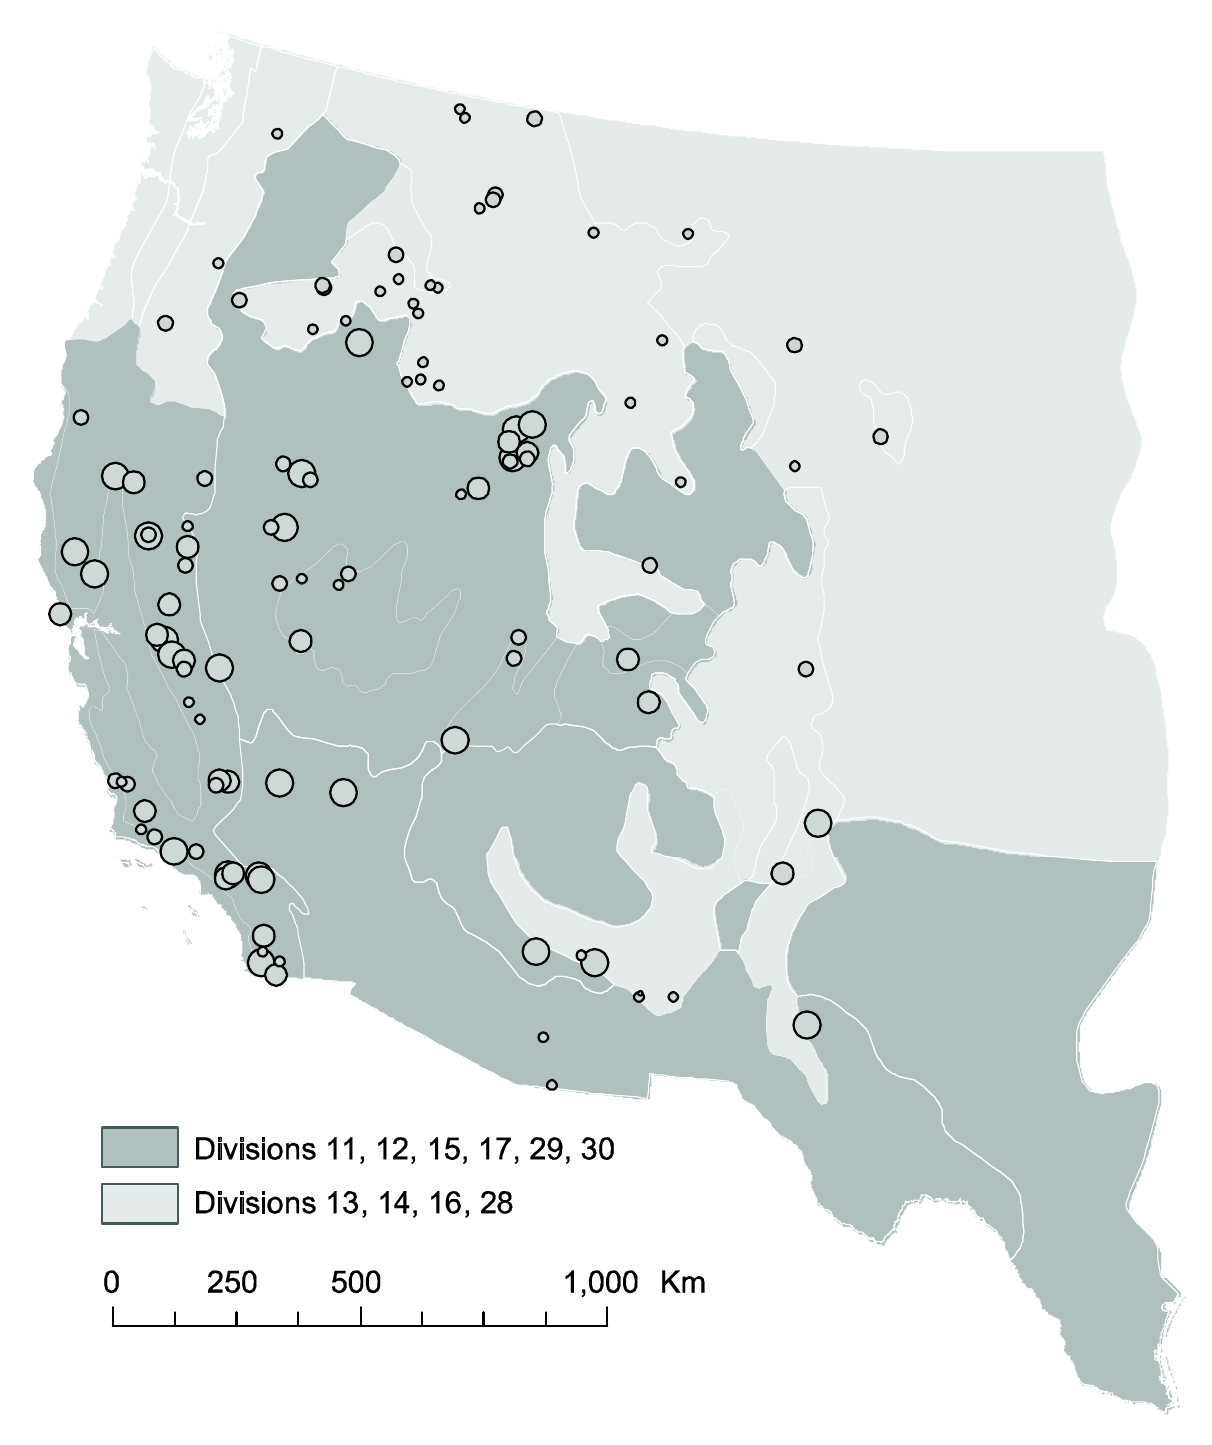
Figure 4. Map of study region, showing fire locations. Size of circles indicates magnitude of the post-fire NDVI slope (higher slopes indicated by larger circles). Bailey’s ecoregion Divisions are outlined in white. CART analysis estimated that Divisions 13, 14, 16, and 28 have a lower post-fire NDVI slope (0.214) than the remaining Divisions